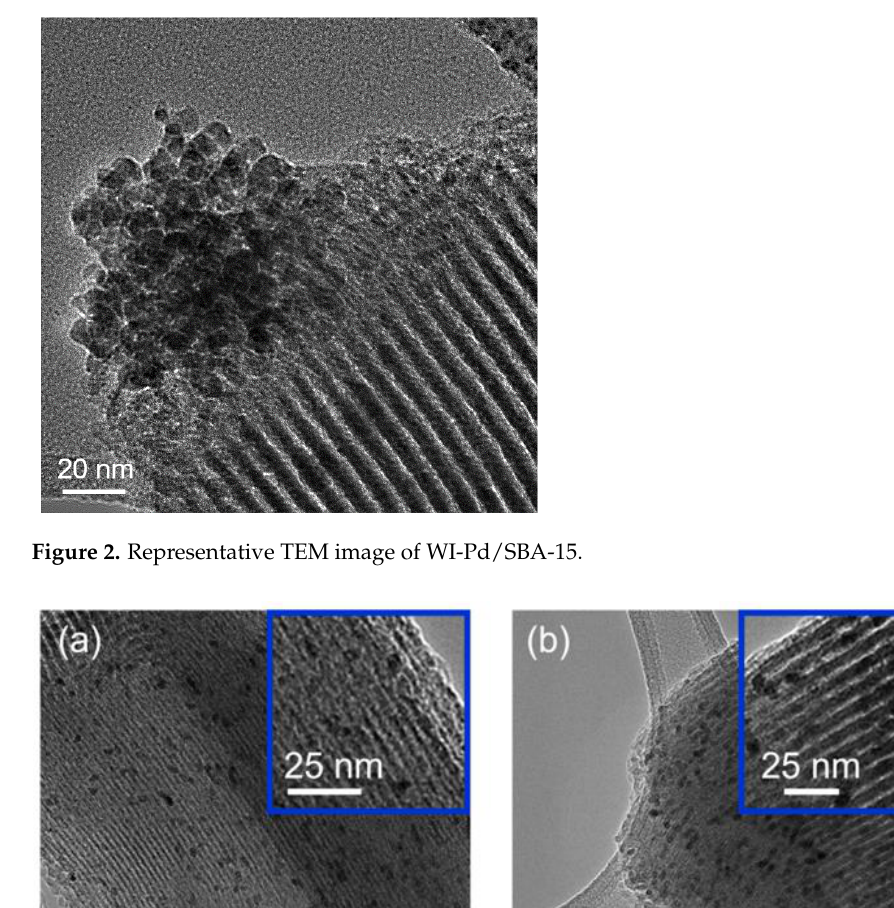
Figure 2. Representative TEM image of WI-Pd/SBA-15.